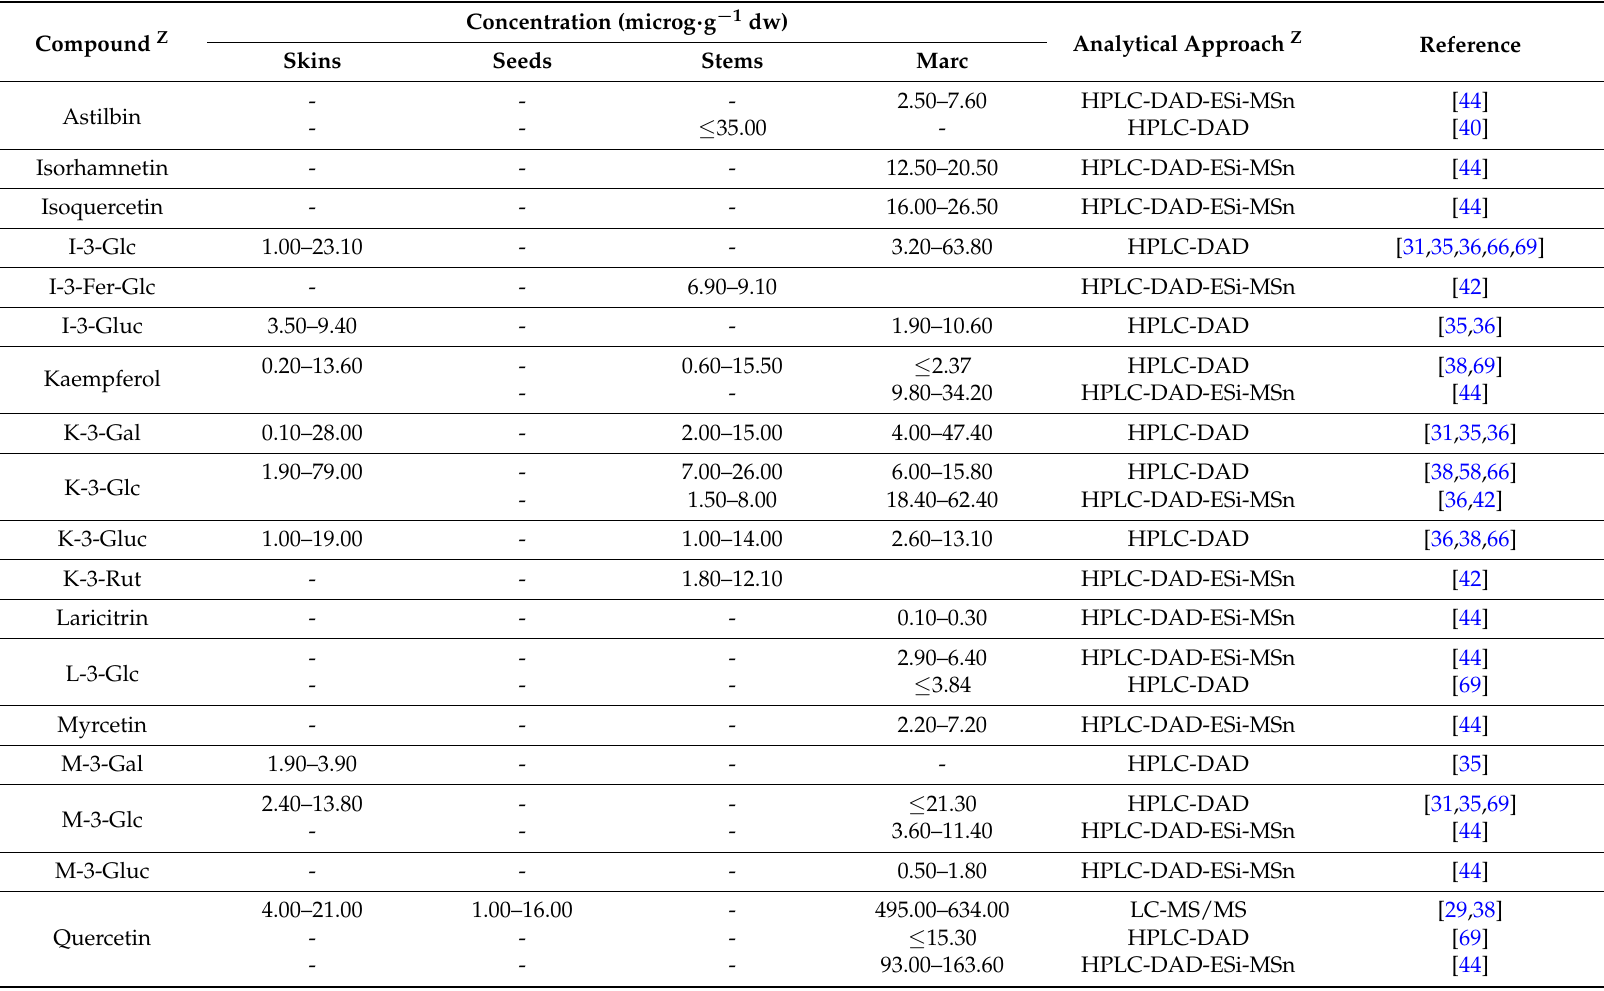
Table 3. Flavonols present in winery